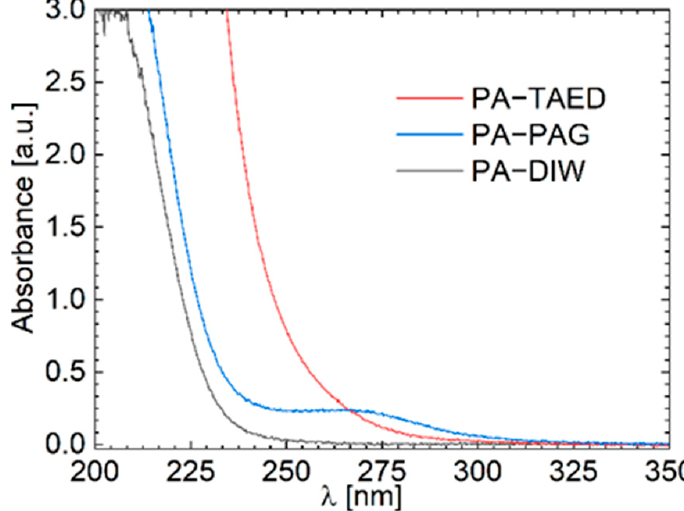
Figure 6. UV-vis spectra of the PA-DIW, PA-TAED and PA-DIW. Based on our previous investigations, we determined that the main antibacterial efficacy of plasma activated acetyl donors is attributed to H 2 O 2 and PAA [2]; however, we note that other molecules in the solution will also contribute to killing bacteria but are produced by plasma at much lower concentrations compared to H 2 O 2 and PAA. Therefore, the concentrations of H 2 O 2 and PAA produced in the plasma activated acetyl donor solutions was measured to obtain an indication of their potential antibacterial activity. Figure 7a,b shows the concentration of H 2 O 2 and PAA, respectively, produced in PA-DIW, PA-TAED and PA-PAG. The highest H 2 O 2 concentration was 5.0 mM produced in PA- TAED, followed by PA-PAG at 4.2 mM and PA-DIW at 2.5 mM. PA-PAG contained the highest PAA concentration at 6.3 mM compared to PA-TAED at 2.0 mM. As expected, PAA was not detected in PA-DIW due to the absence of acetyl donors. Figure 8 shows the pH of the plasma activated solutions. Addition of acetyl donors increased solution acidification with the lowest pH detected in PA-PAG.